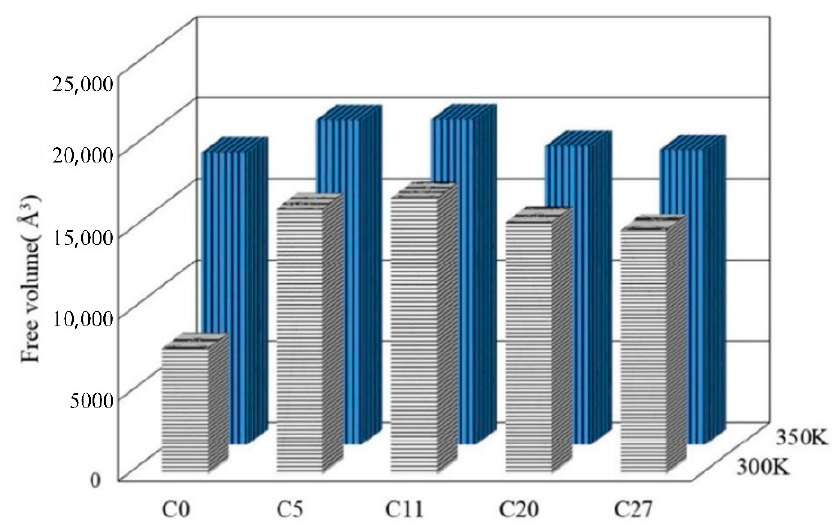
Figure 12. Free volumes, simulated by MD models, for five systems at 300 and 350K [94].